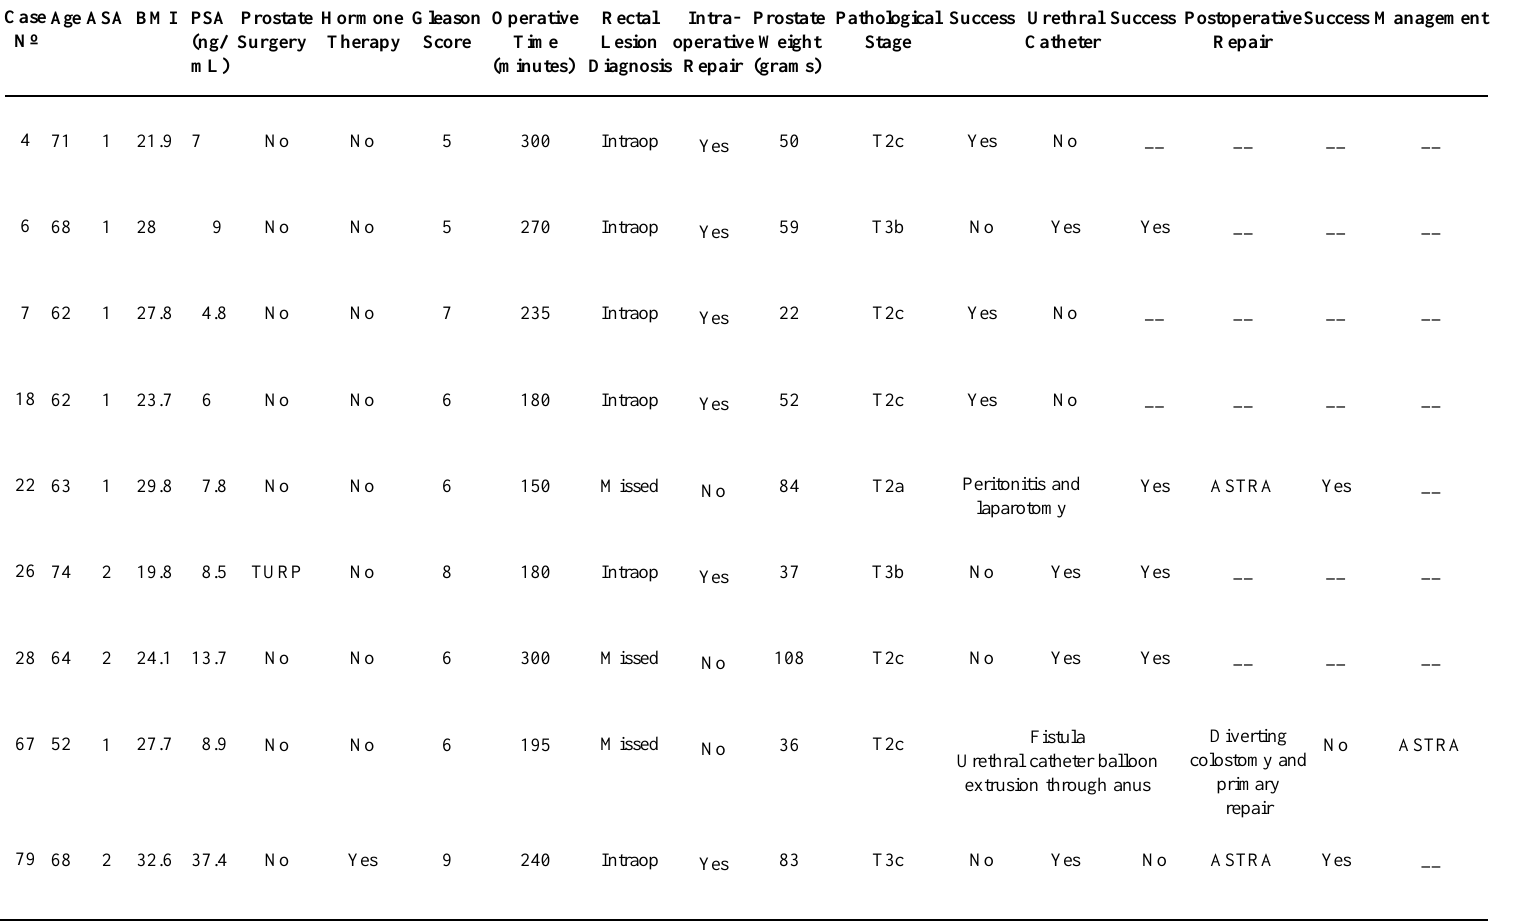
Table 1 – Patient